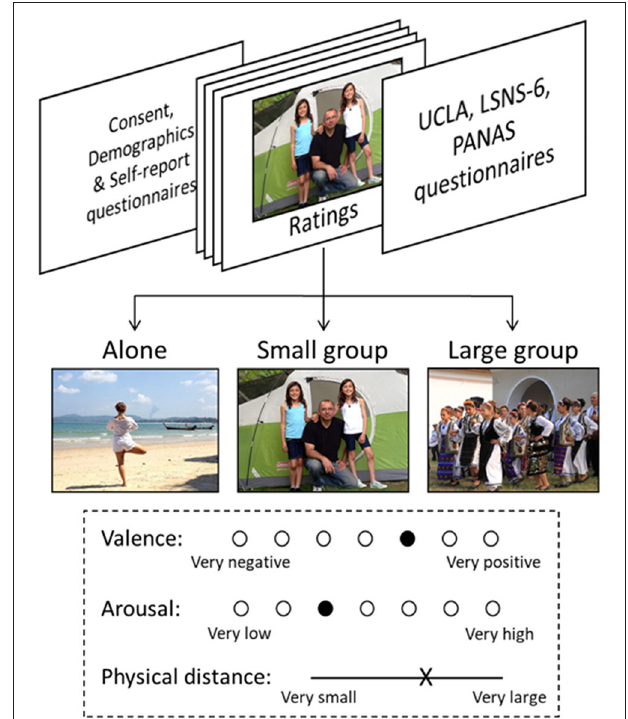
FIGURE 1 | Overview of the study and examples of the three categories of images: Alone, Small group, and Large group. Ratings of perceived physical distance between people were collected only for images depicting more than one individual. Images are from the OASIS database ( Kurdi et al., 2017).